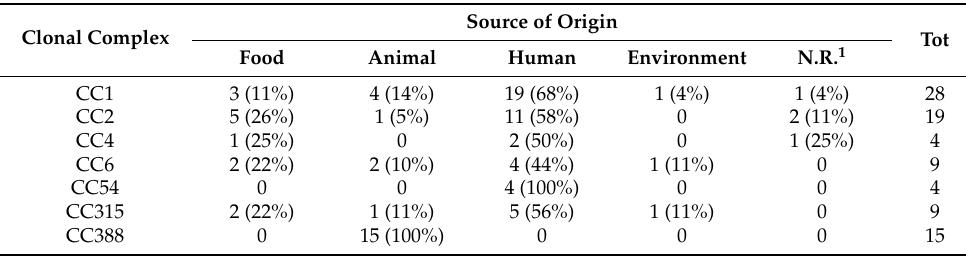
Table 2. Source of origin of the 88 L. monocytogenes serogroup IVb isolates from Europe associated with the CC